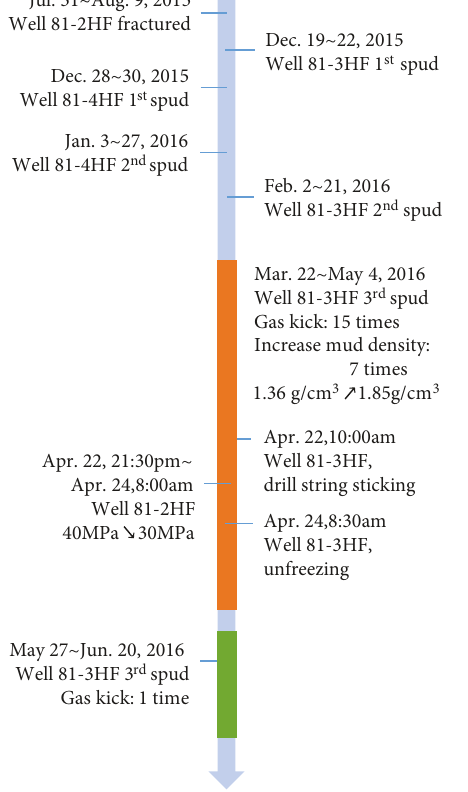
Figure 11: Main related events in the three nearby wells in chronological